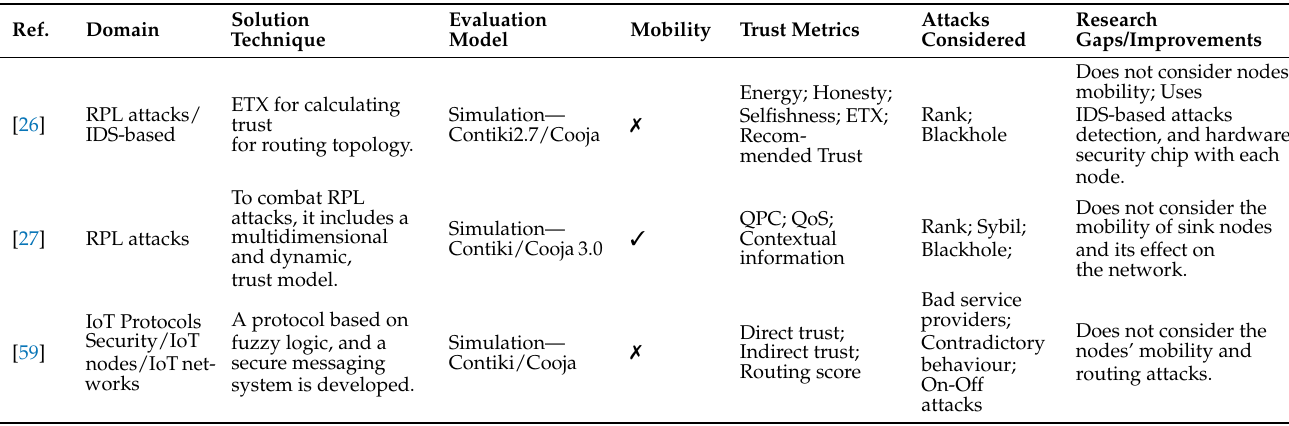
Table 2. Related Work for Trust-Based Methods for Routing